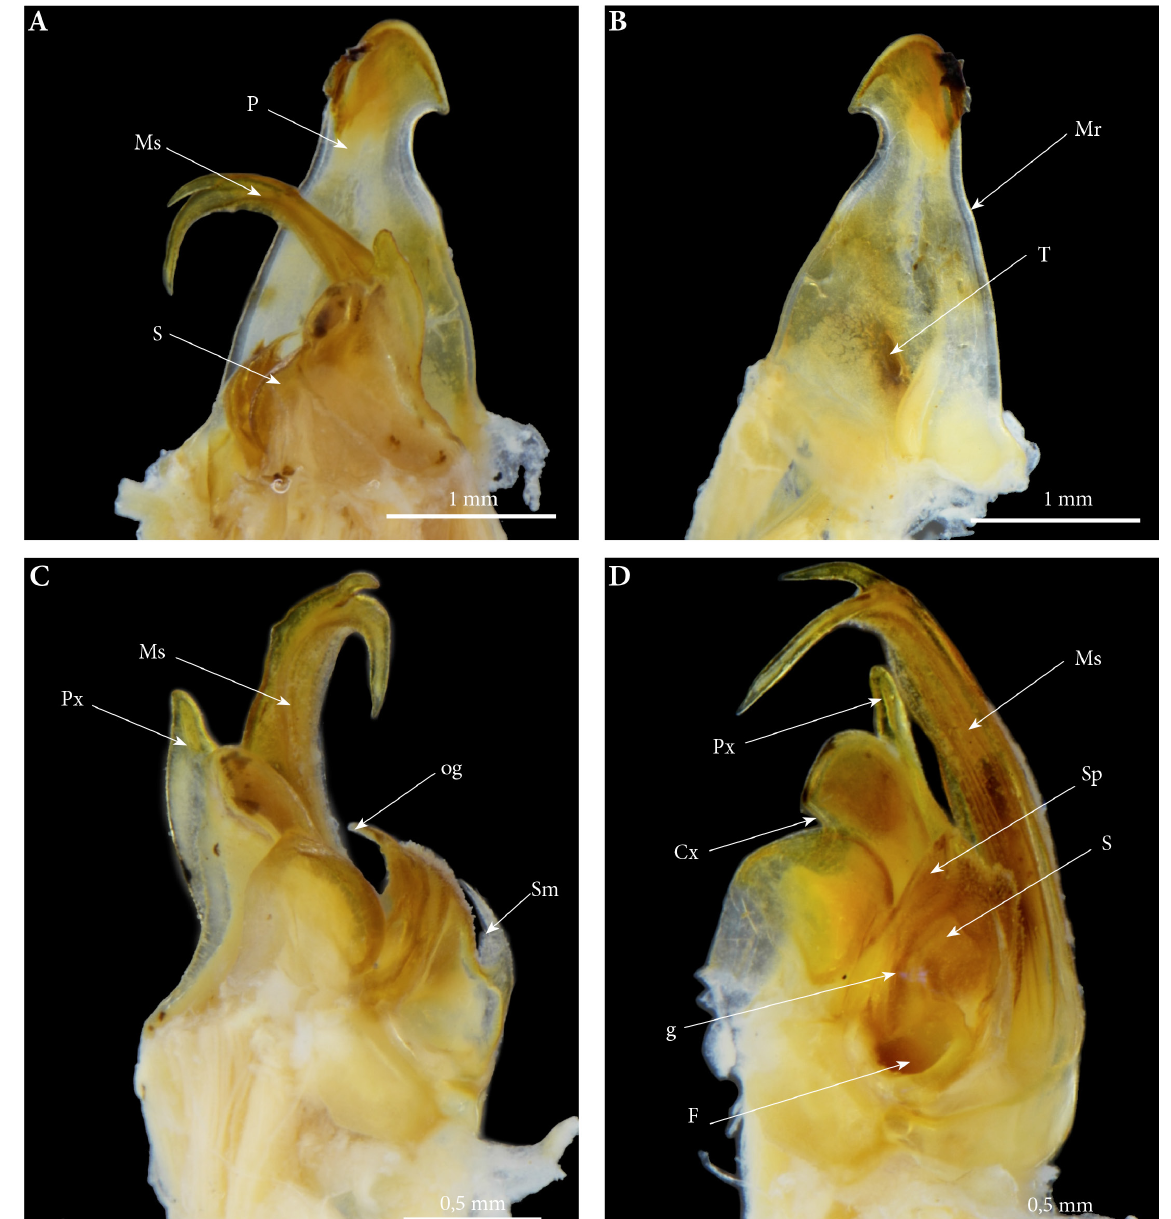
Fig. 7. Ommatoiulus camurus sp. nov. Holotype, ♂. A . Left gonopod, posterior view. B . Right promerite, posterior view. C . Right posterior gonopod, lateral view. D . Left posterior gonopod, mesal